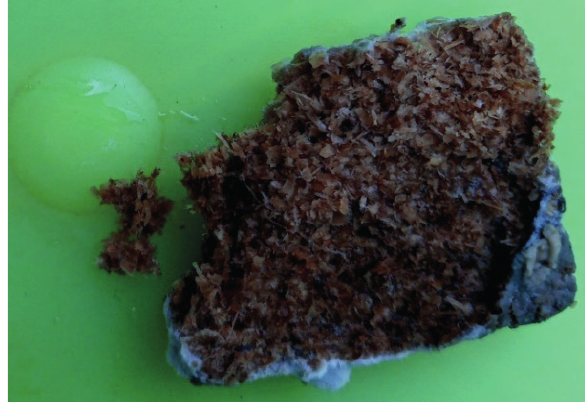
Figure 2 Average values of compression elasticity modulus, breaking stress, yield strength, and elastic modulus in flexure of plastics without adhesives